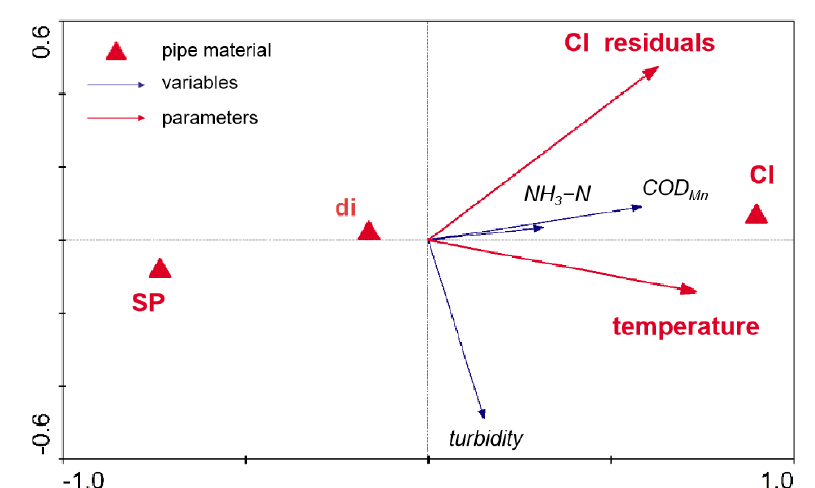
Figure 4. Redundancy analysis (RDA) ordination triplot of environment factors and water quality indicators over a long period. Red triangles represent three kinds of pipe material; red arrows represent variables: temperature and chlorine residuals; blue arrows represent parameters: turbidity, COD Mn , and NH 3 -N.